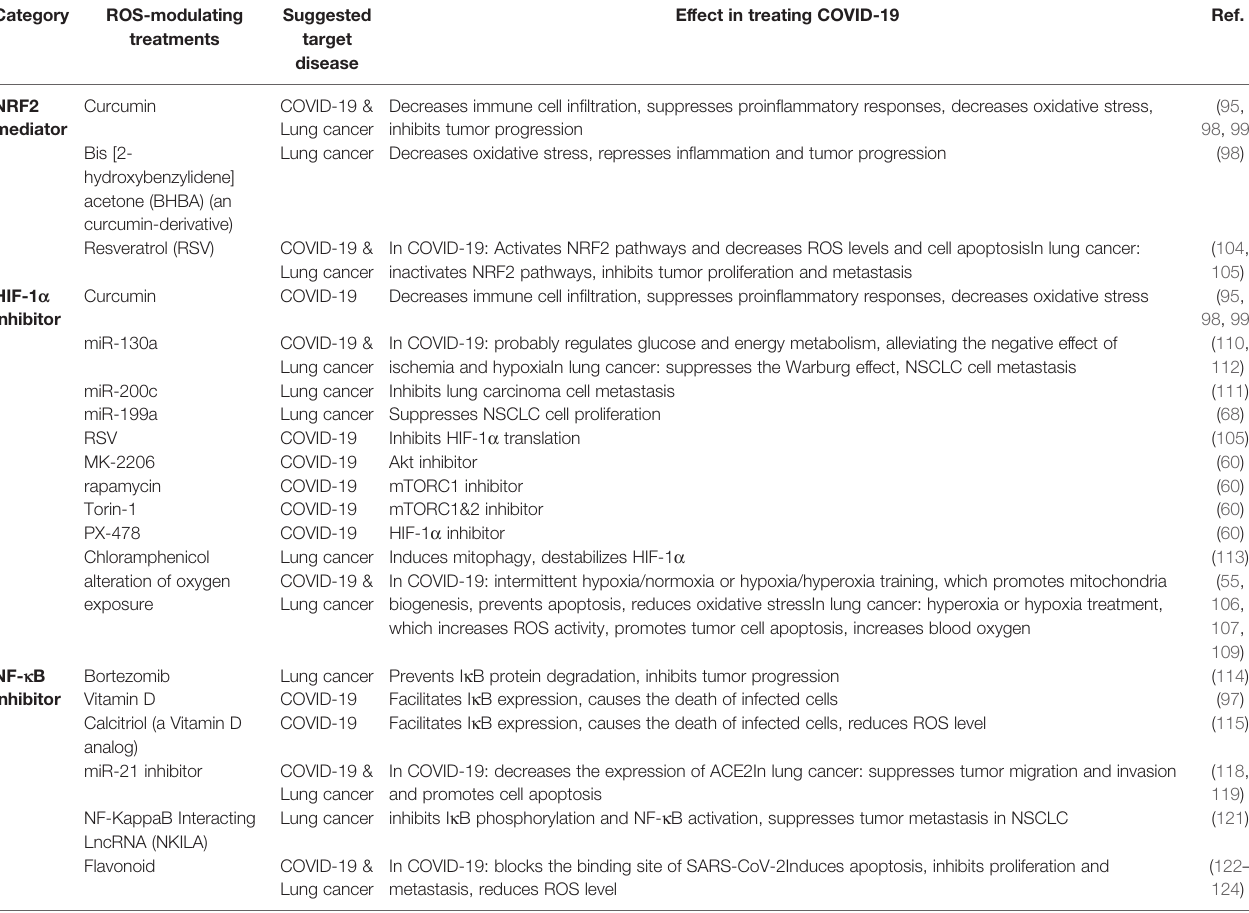
TABLE 2 | ROS-modulating compounds and their effects in reversing COVID-19 and lung cancer. Category ROS-modulating Suggested treatments target